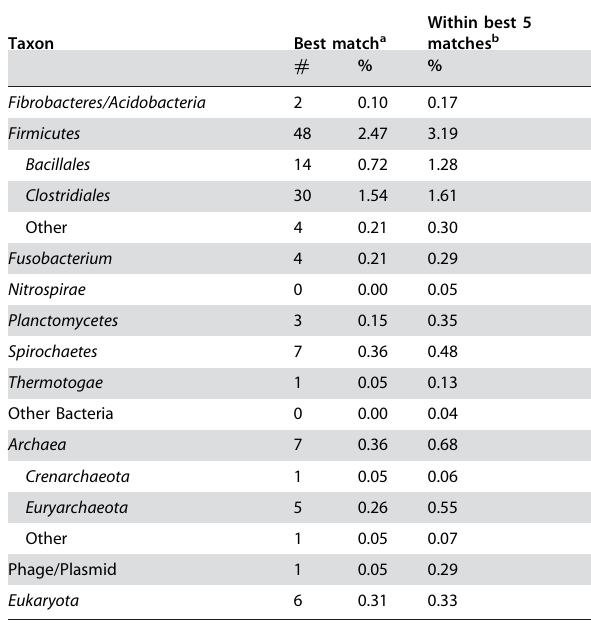
Top matches are derived from Table S3. Predicted Arcobacter butzleri proteins were compared to proteins in the NCBI non-redundant (nr) database by BLASTP. Matches with an Expect ( E ) value of . 1 6 10 2 5 , an identity of , 25%, and an alignment length across either the query or match sequences of , 75% were excluded. The top five matches (where applicable) were identified at each locus (Table S3) and classified by taxon. Individual orders are listed if they constitute . 1% of the total. a A total of 1944 loci contained matches to proteins in the nr database, according to the criteria listed above. Percentage values for the defined taxa do not include the 315 loci (13.9% of the 2259 identified loci) for which no homologs were identified. b Multiple strains of the same species (e.g. C. jejuni RM1221 and C. jejuni NCTC 11168) at a given locus were counted once. Percentage values for the defined taxa do not include the 315 loci for which no homologs were